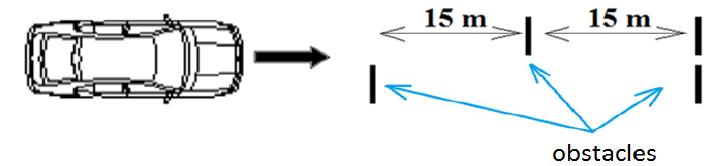
Figure 1. Obstacle on the road.